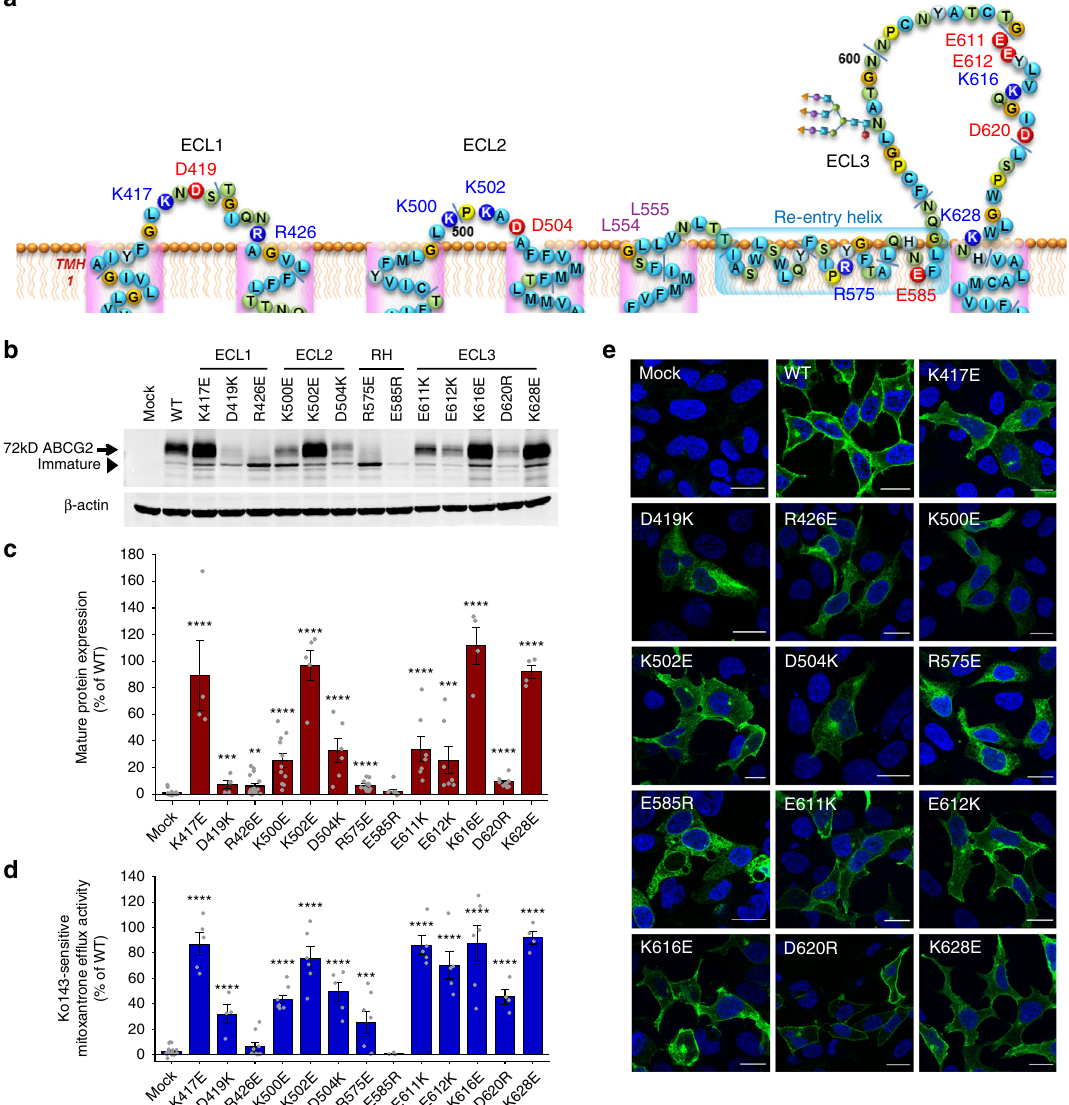
Fig. 1 Charged residues in the extracellular roof are critical for ABCG2 function. Mutational analysis of residues in the putative extracellular membrane interface. Charged residues located in the ECL1, ECL2, re-entry helix, and ECL3 were subjected to mutational analysis: a Predicted membrane topology of extracellular regions in the human ABCG2 transporter. Re-entry helix is highlighted in light blue box; consensus glycosylation site is at N596. Residues subjected to mutagenesis are indicated; positively charged residues (blue); negatively charged residues (red). b Immunodetection of ABCG2 mutant variants using the monoclonal anti-ABCG2 (BXP-21) antibody. Mature wild-type (WT) protein migrates at ~72 kDa, the immature unglycosylated bands migrate just below. β -Actin was used as an internal loading control. c Odyssey-based quanti fi cation of immunoblots from several independent experiments ( n = 3 – 15). Mature ABCG2 and β -actin bands are shown, and ABCG2 signals were individually normalized to β -actin and represented as the percentage of WT control. d Mitoxantrone ef fl ux is shown for HEK293 cells expressing ABCG2 variants after incubation at 37 °C for 20 min in the presence and absence of the ABCG2 inhibitor Ko143. Ko143-sensitive mitoxantrone ef fl ux is represented as percentage relative to the WT control. Data are from several independent experiments ( n = 3 – 9). All data are shown as means ± SEM. **** P < 0.0001; *** P < 0.001; ** P < 0.01; * P < 0.1 vs. empty plasmid-transfected HEK293 control (mock). Gray dots refer to values from each independent experiment. e Membrane localization of GFP-tagged ABCG2 variants. GFP signals of GFP-ABCG2 (green) were recorded in a confocal microscopy as described in Methods. DAPI was used to stain the nuclei (blue). Microscopy data are from duplicate experiments. Scale bars in microscopy images correspond to 20 µ